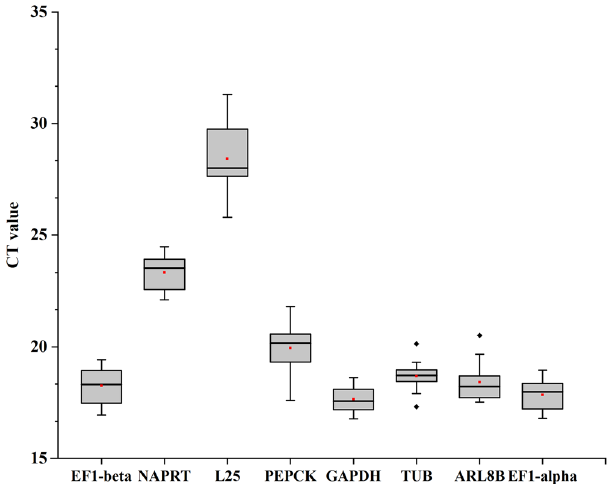
Figure 3. Expression levels of different candidate reference genes. Expression data displayed as qRT-PCR quantification cycle values for each reference gene in P. ternata. The line across the box is depicted as the median. The box indicates the 25th and 75th percentiles and whisker caps represent the maximum and minimum values. The higher the boxes and whisker are, the greater the variations.